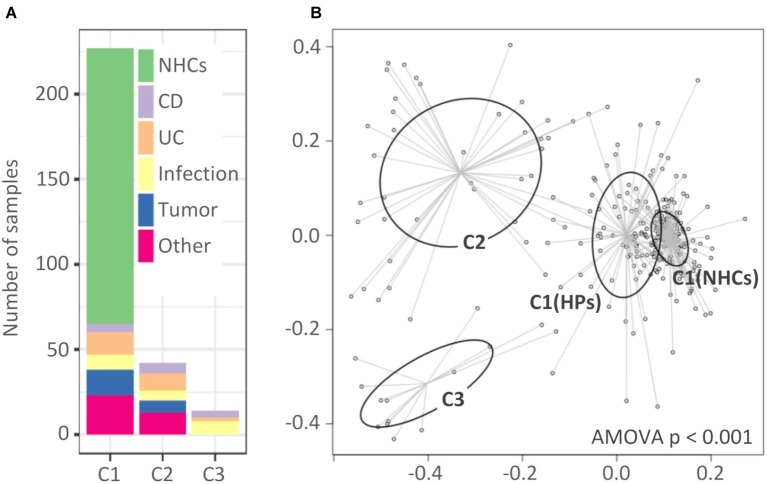
Clusters of hospitalized patients and healthy controls obtained with partitioning around medoids. (A) Distribution of samples in clusters based on their diagnosis-based group affiliation. (B) Non-metric multidimensional scaling (NMDS) presentation of Bray-Curtis distances. The clusters are highlighted with different colors. Cluster C1 was, for the purpose of downstream analysis, divided into C1(NHCs) and C1(HPs). NHCs, healthy controls; CD, hospitalized patients with Crohn’s disease; UC, hospitalized patients with ulcerative colitis; Other, patients with other diagnoses, primarily liver-associated diseases.